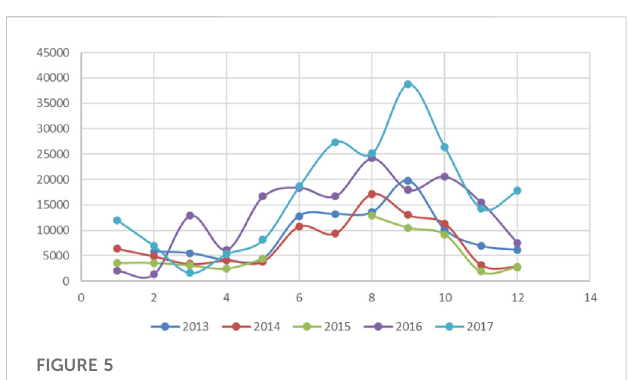
FIGURE 5 Month-wise Deviation in the waste